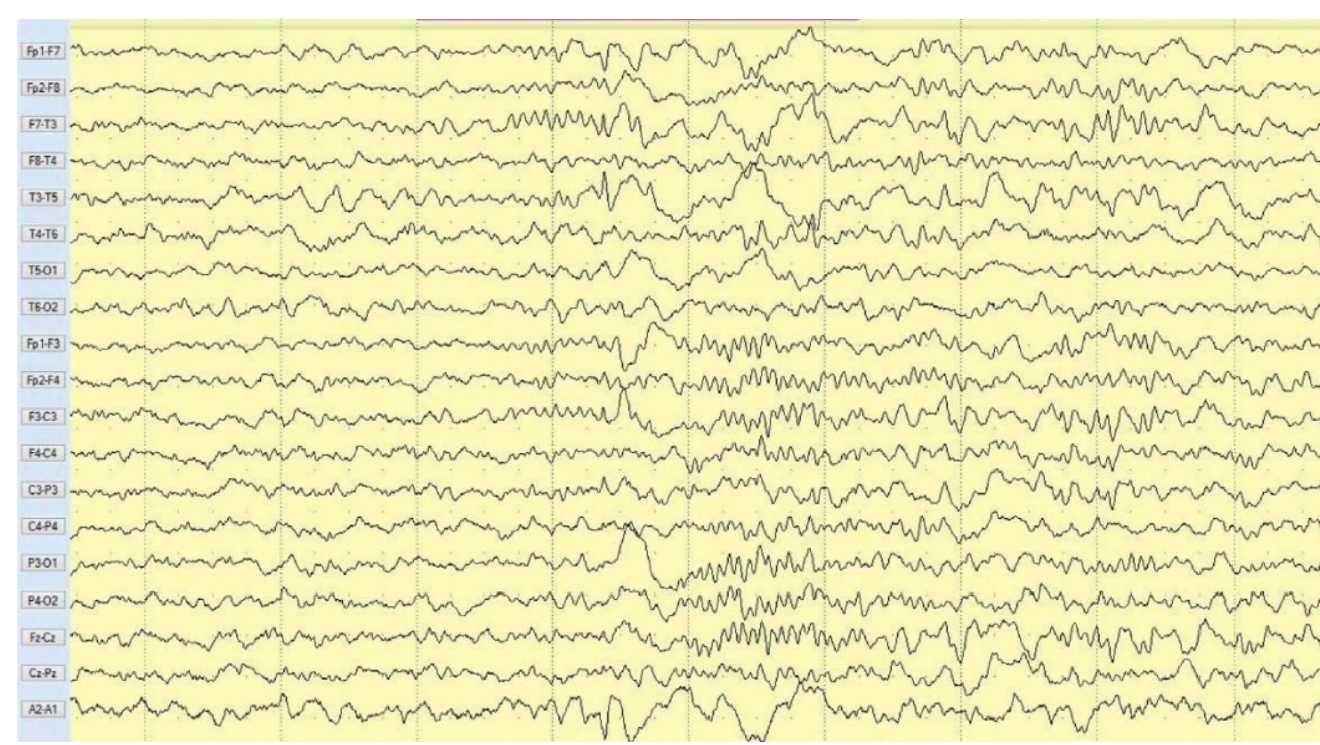
Figure 1. Electroencephalography (EEG) fragment of a patient with epilepsy